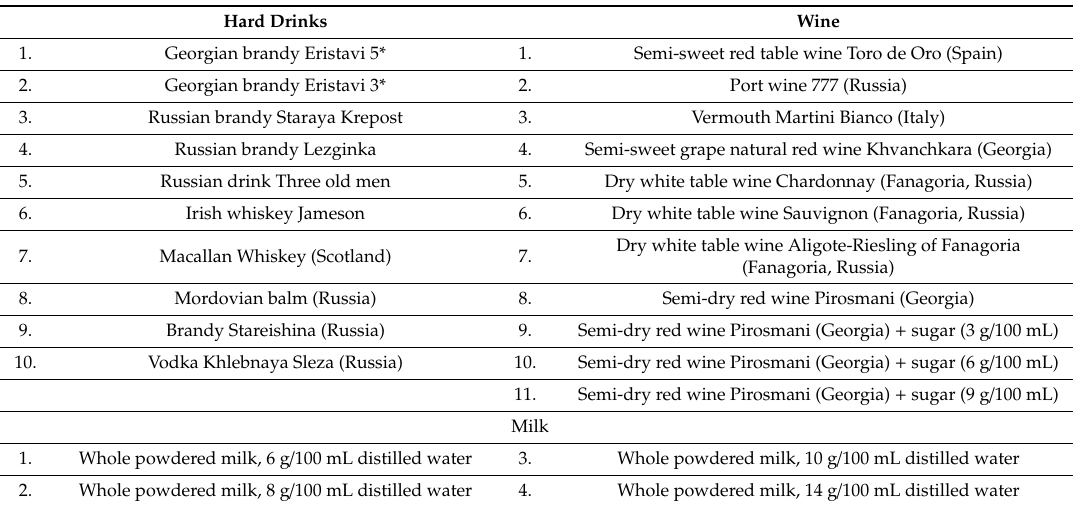
Figure 7 . Software interface (a,b). A variety of shapes of hodographs of liquids of different classes: 1 - dry red wine; 2 - cognac; 3 - whiskey; 4 - balm; 5 - vodka. Table 1. List of the samples under